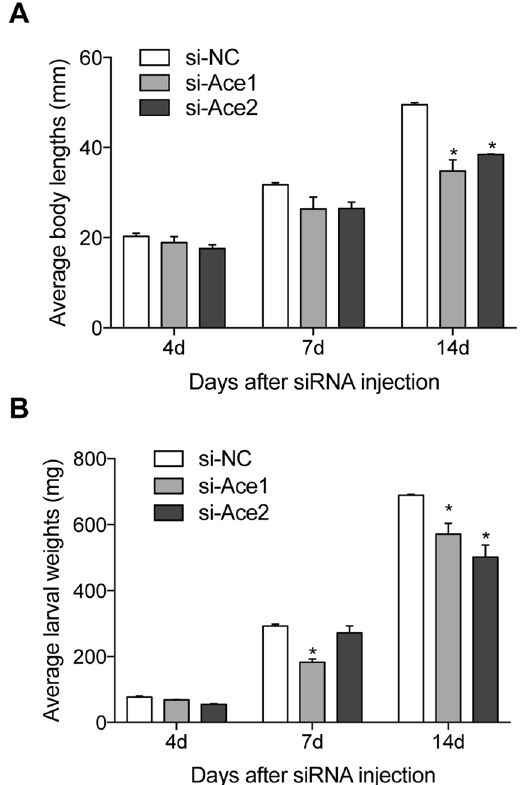
Figure 5. The siRNA treatments influenced larval development. Panel A: Mean larval body lengths of siRNA- treated silkworms at the indicated d PI. The histogram bars indicate mean body lengths and the error bars indicate 1SEM. * Significant difference at P ≤ 0.05. (B) Mean larval weight of siRNA treated silkworms at 4, 7 and 14 d PI. The histogram bars indicate mean body wet weights and the error bars indicate 1SEM. * Significant difference at P ≤ 0.05. All experiments were repeated in triplicate, n = 30.